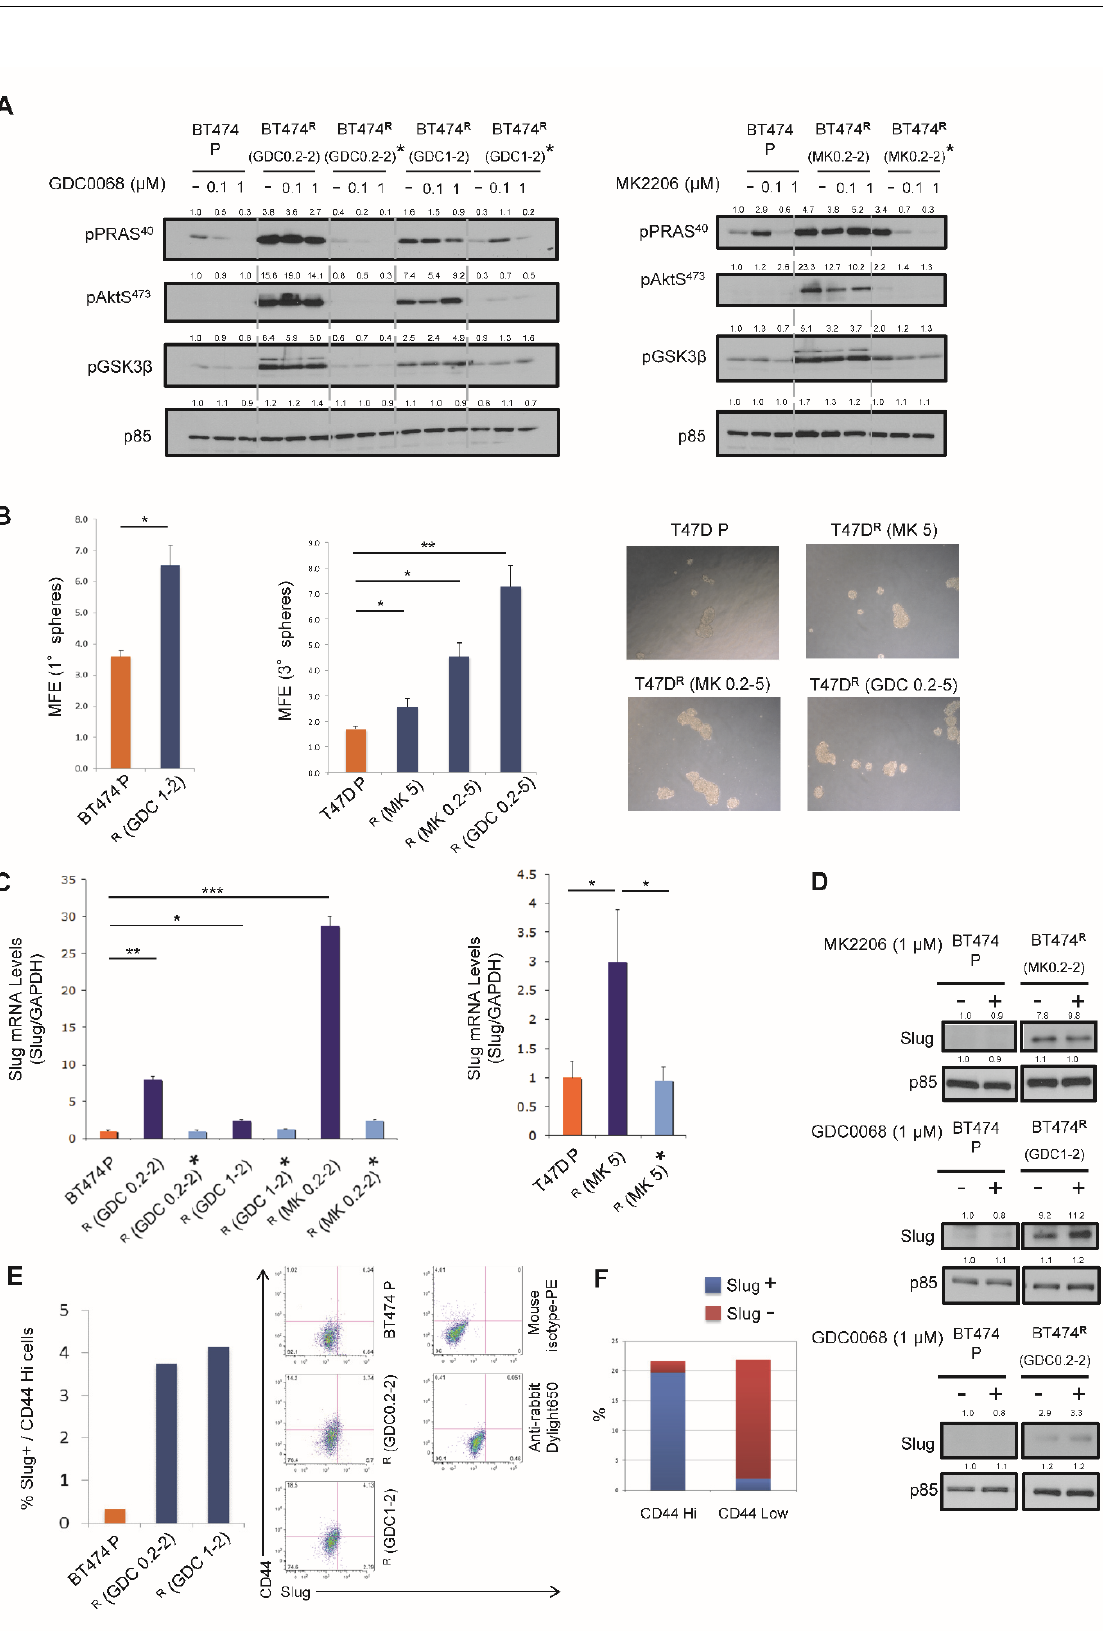
Figure 3. Upregulation of CSC phenotypes in Akt-inhibitor-resistant tumor cells. ( A ) BT474 parental and Akt-inhibitor-resistant cells were seeded to plates in the absence of Akt inhibitor for 48 h. Cells were then treated with MK2206 or GDC0068 for 1 h. Whole-cell lysates were subjected to immunoblotting. * Resistant cells were cultured in the absence of Akt inhibitor for 3.5 weeks, before Western